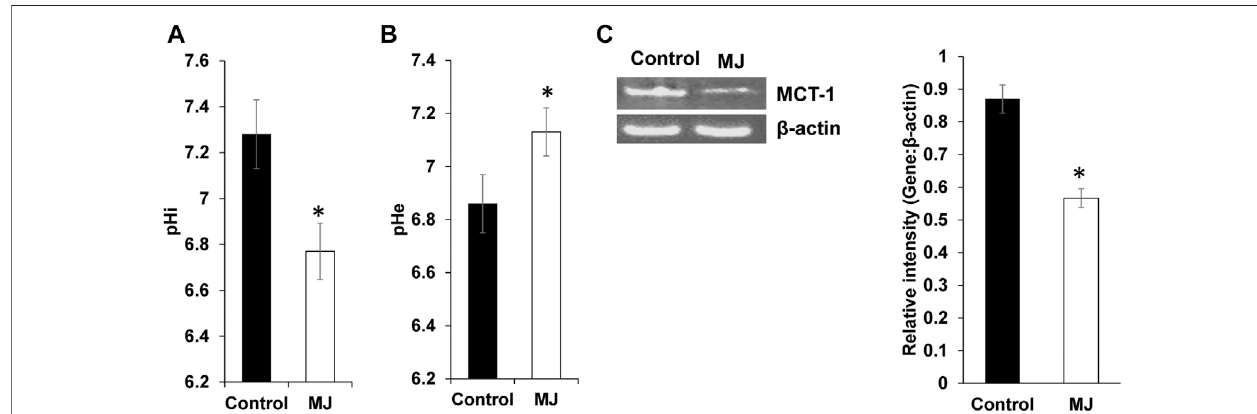
FIGURE4| MJmodulatespHhomeostasisoftumorcells.Tumorcells(1 × 10 5 cell/ml)wereincubatedinmediumaloneorcontainingMJ(2.5 mM)for18 hfollowed by estimation of pHi (A) and pHe (B) as described in the materials and methods. Values shown in the bar diagrams (A,B) are mean ± SD of three independent experiments. * p < 0.05 vs. respective control. Expression of pH regulator MCT-1 was analyzed in the cell lysate of control and MJ-treated tumor cells (1 × 10 5 cell/ml). Bands (C) shown are from representative experiments out of three with a similar pattern. (C) . The accompanying bar diagrams are densitometric analysis of the bands (C) . Values shown are mean ± SD. * p < 0.05 vs. respective